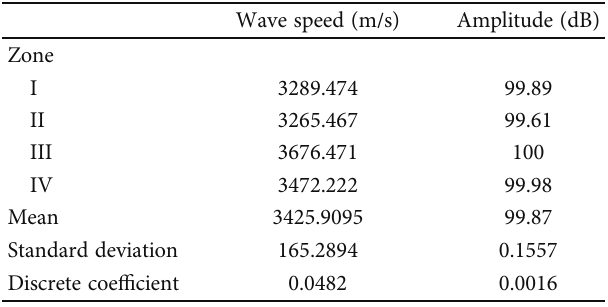
Figure 6: De fi nition of acoustic emission waveform parameters. Table 1: Acoustic emission experiment results of intact